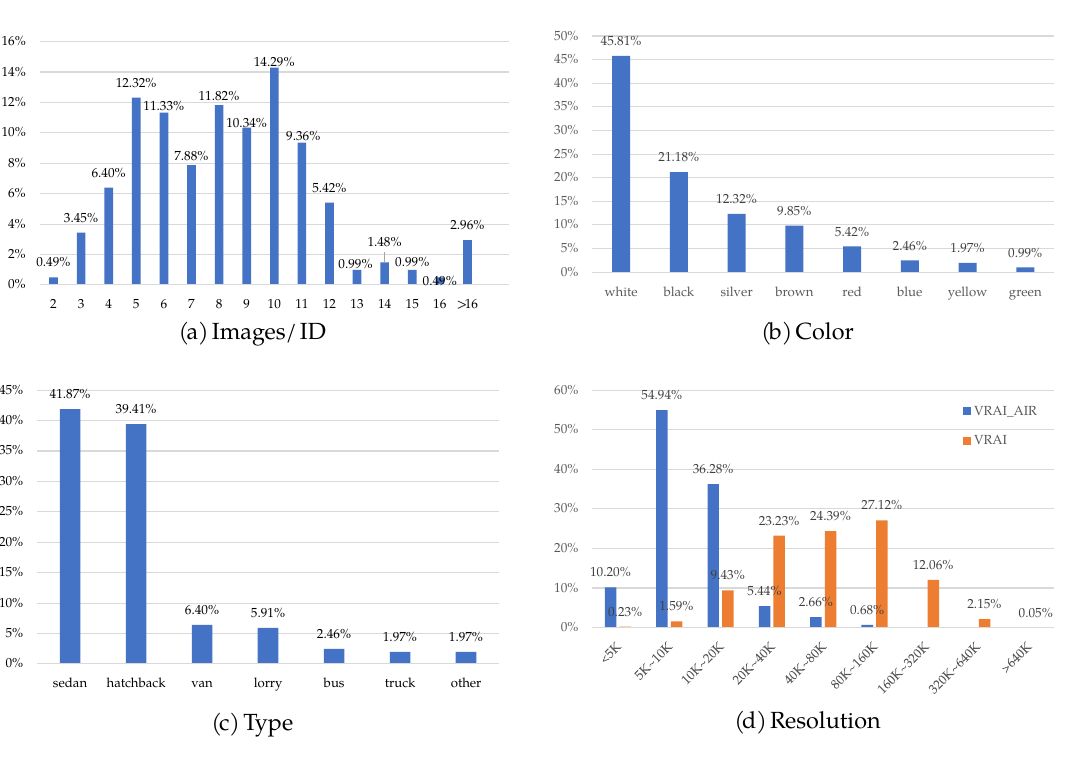
Figure 7. Image attributes of